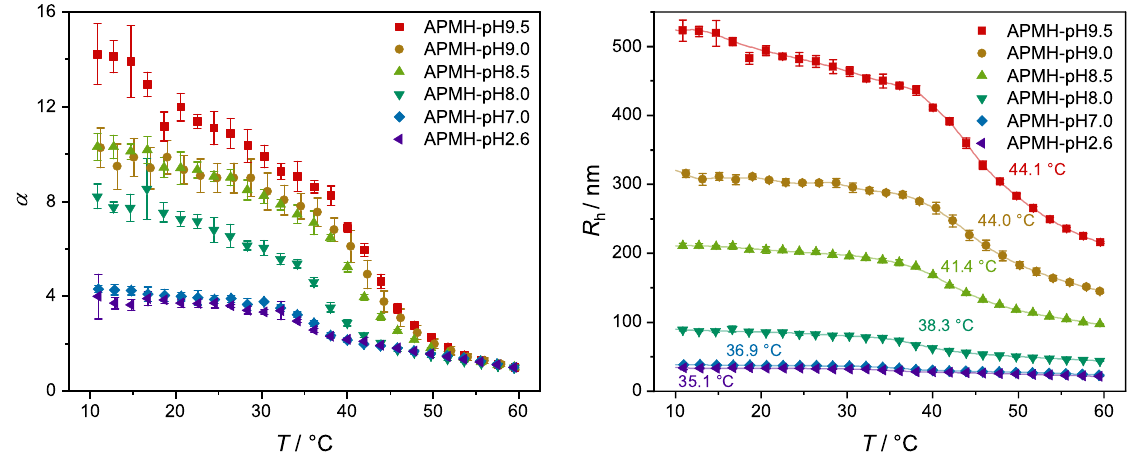
Figure 8. Temperature-dependent swelling behavior, plotted by means of the hydrodynamic radius R h and the volume swelling ratio α . The corresponding VPTTs, determined from the point of inflection of the cubic B-splines, are given in the right